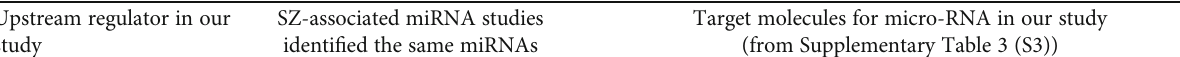
(from Supplementary Table 3 (S3))